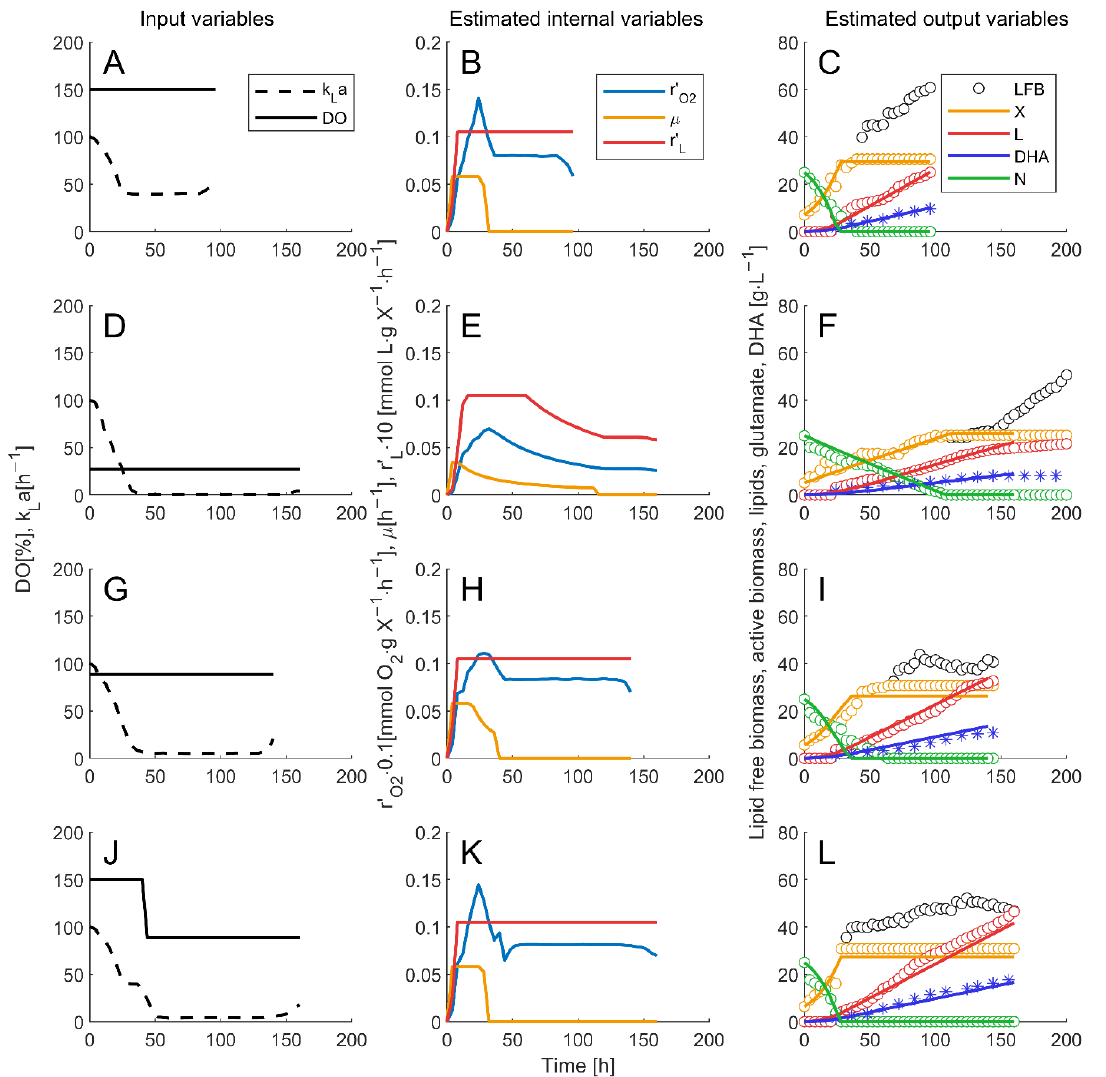
Figure 3. Soft sensor output variables in ( C , F , I , L ) obtained from estimated internal variables related